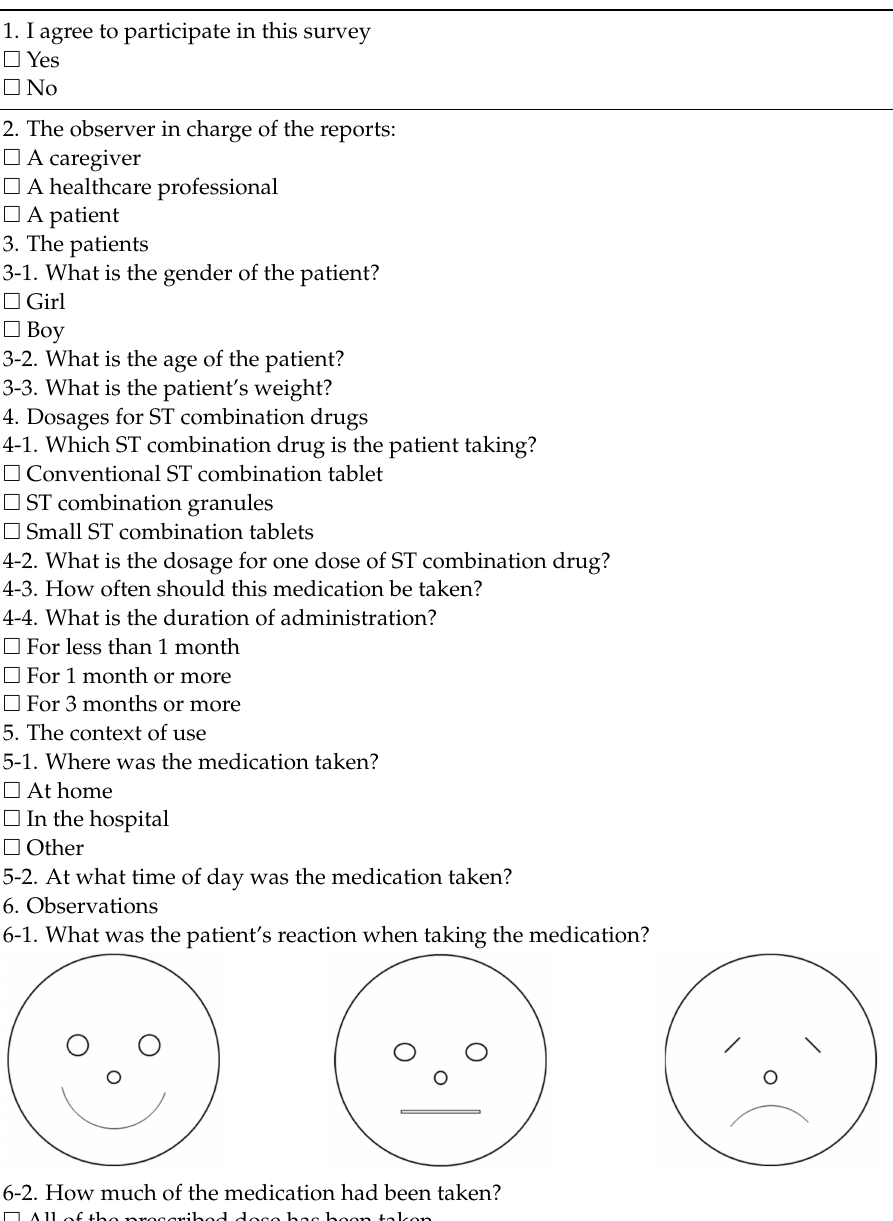
Table 1. Questionnaire sheet (translated into